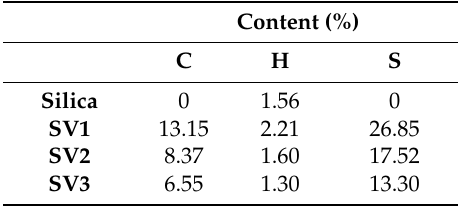
Table 2. Elemental analysis of silica and silica-s-VA7.